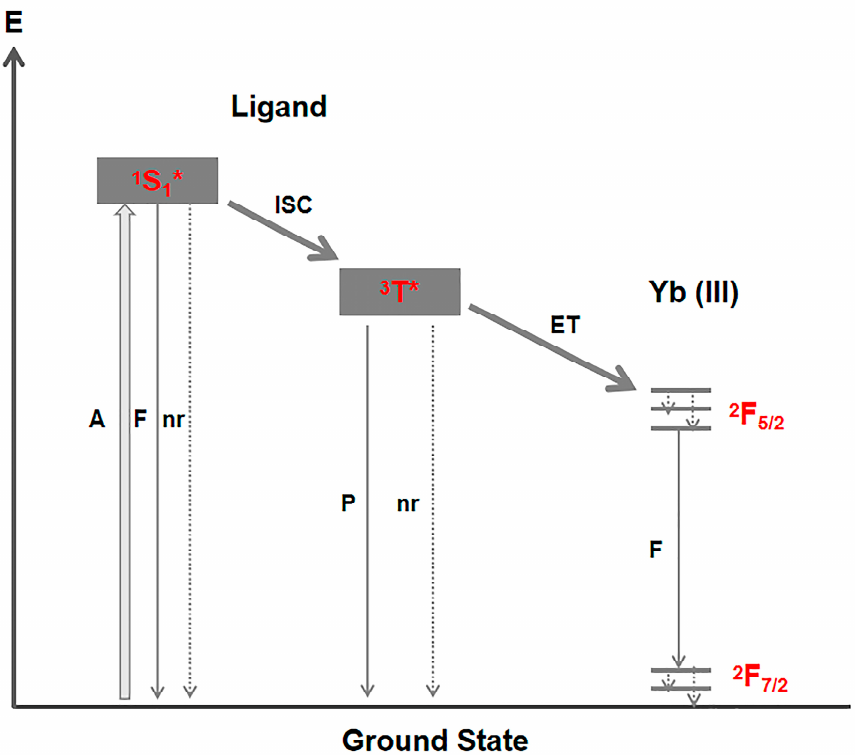
Figure 5. Schematic representation of energy transfer mechanism of ytterbium complexes (A = absorption, F = fluorescence, P = phosphorescence, nr = non-radiative, ISC = intersystem crossing, ET = energy transfer, 1 S 1 * = singlet state, 3 T* = triplet state).